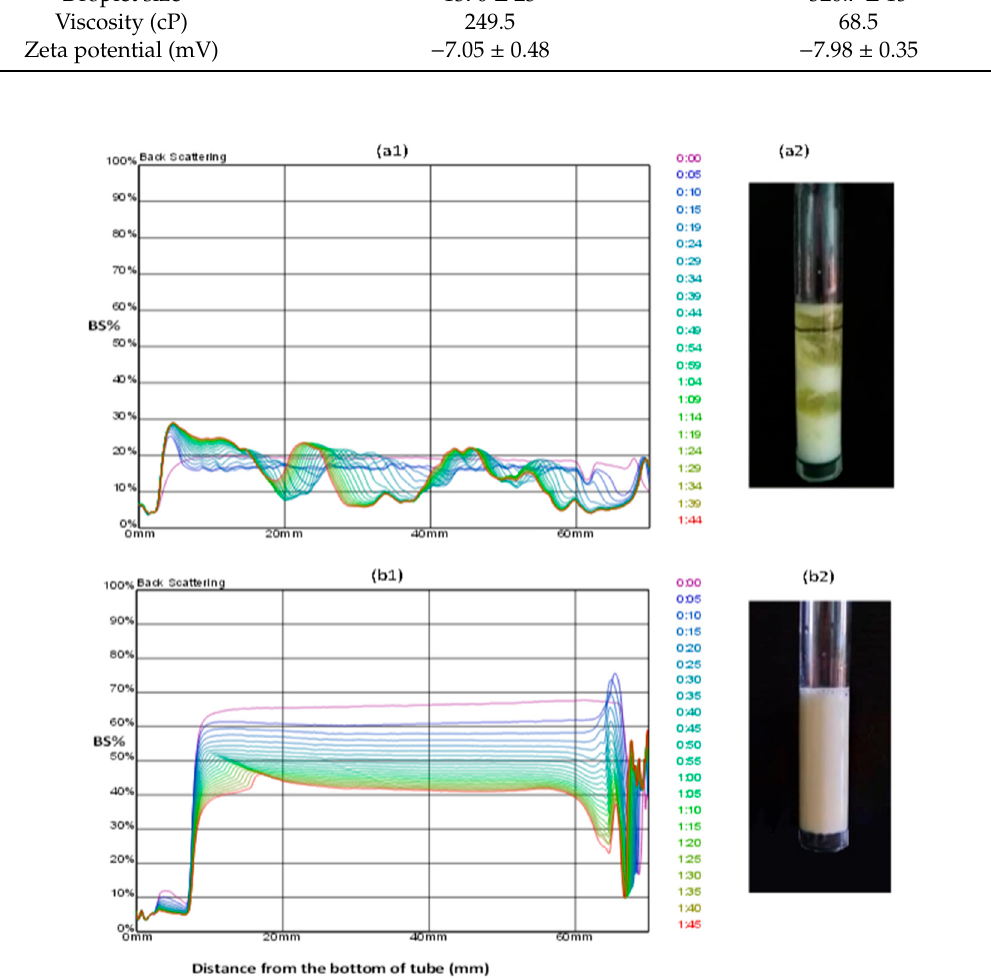
Figure 3. Back scattering (%) vs distance profiles taken every 5 min (recording time increases top to bottom) for non-sonicated ( a1 ) and sonicated ( b1 ) emulsions with 60% SEDDS and corresponding pictures ( a2 and b2 ) taken at the end of the experiments.